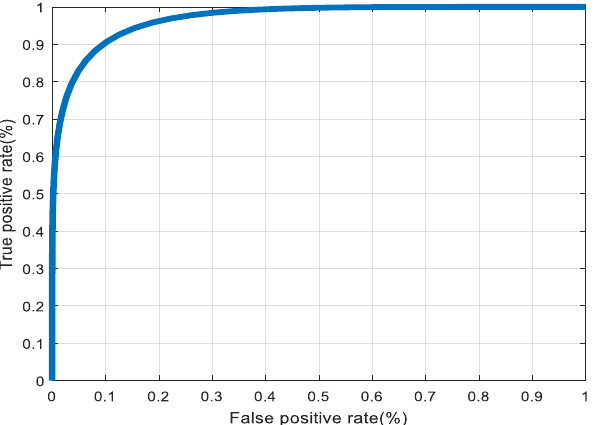
Figure 17. ROC curves for the system using an encrypted kernel with the circular encryption with noise variance = 0.02.